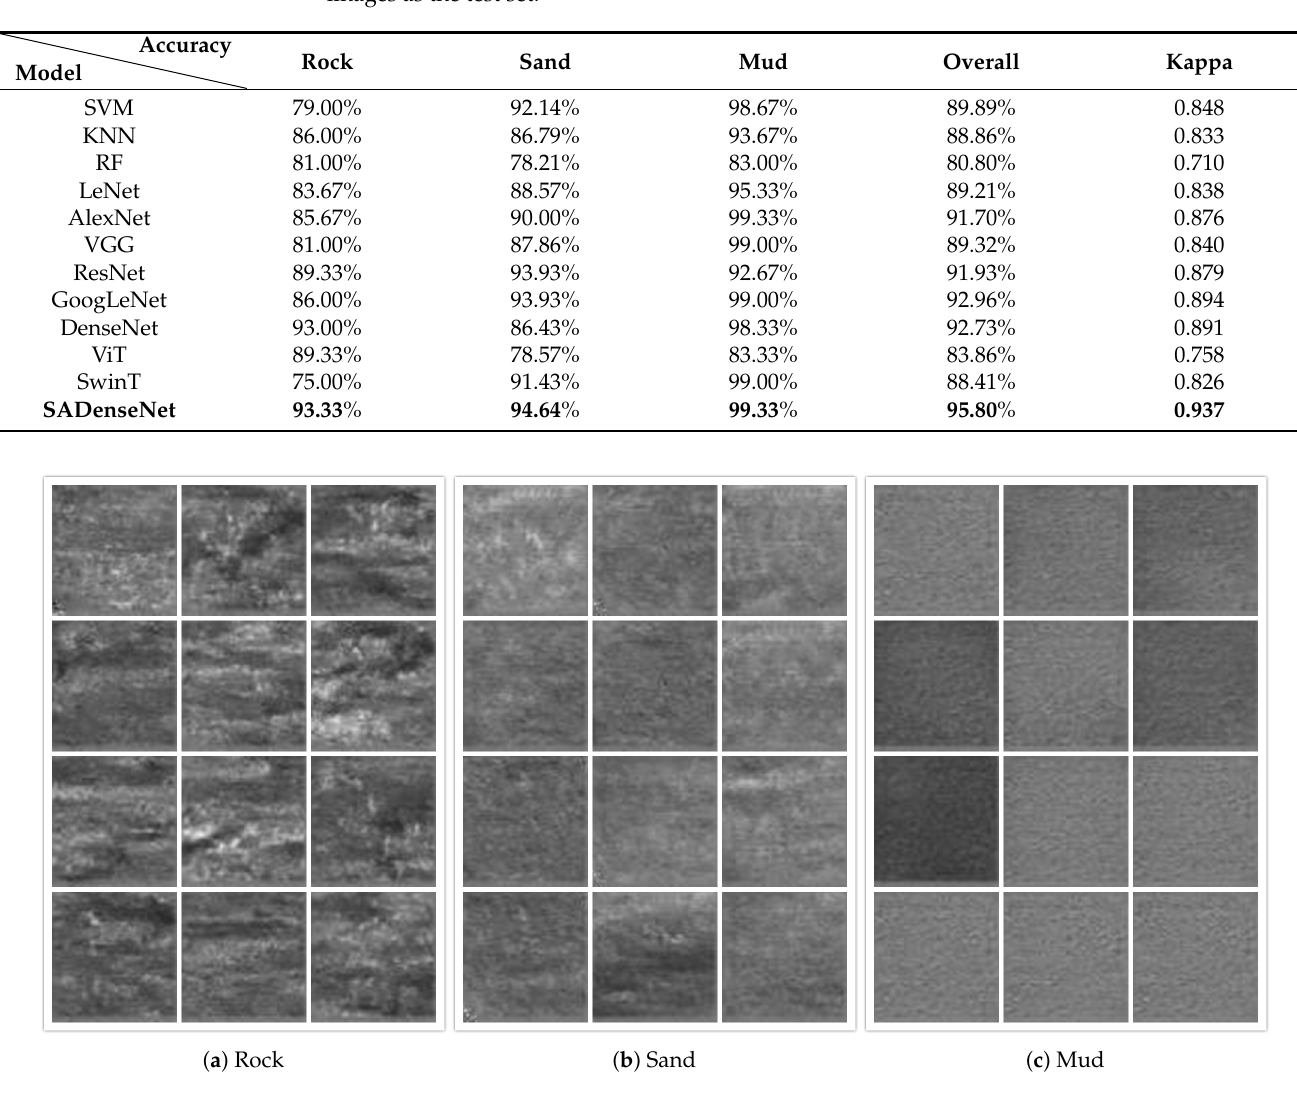
Table 6. Classification accuracy and kappa coefficient using the original training set and the generated images as the test set.